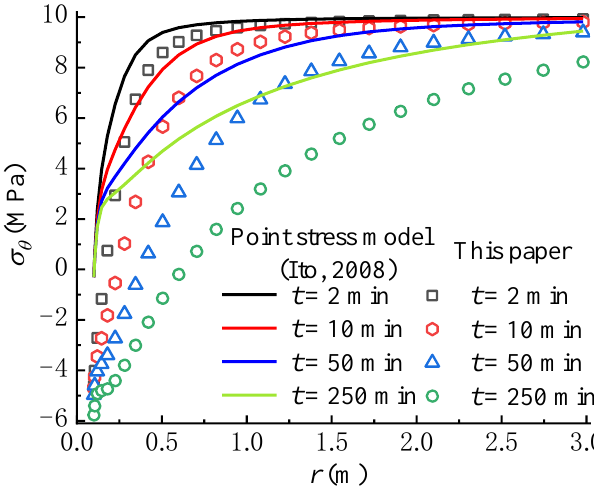
Figure 10. Comparison with the point stress model (Ito, 2008) [22].